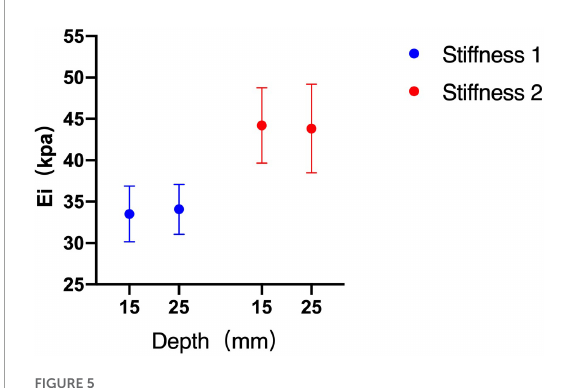
FIGURE5 Shear wave elastography (SWE) measurements between depths of 15 and 25 mm. There was no significant difference between the two